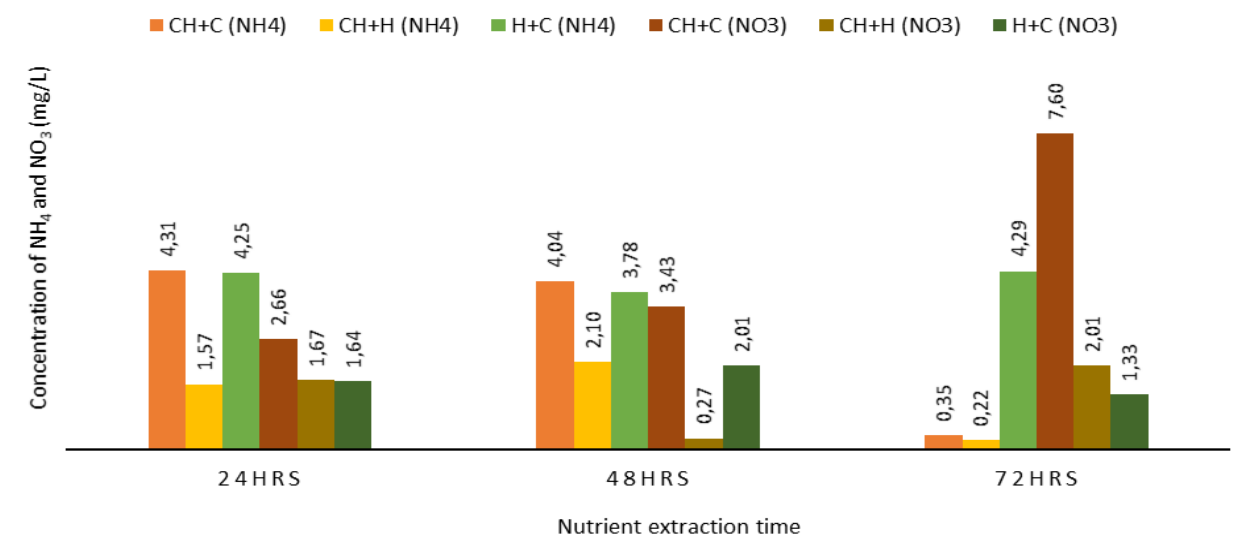
Figure 1. Determination of ammonia and nitrate in different vermicompost teas over 72-h extraction period.